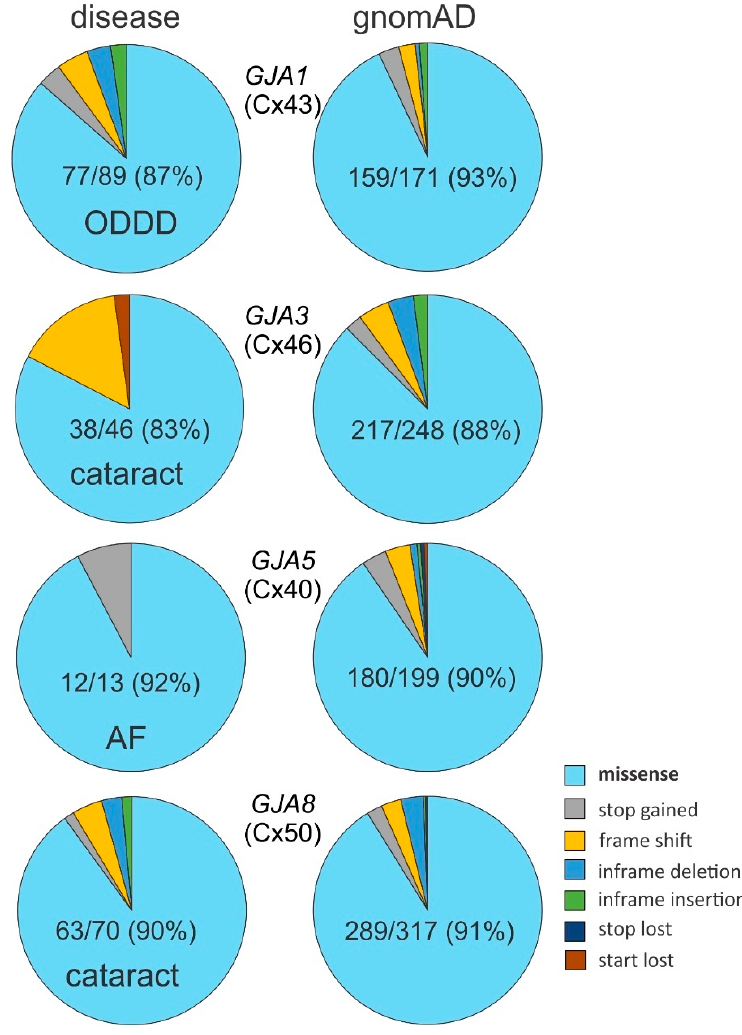
Figure 3. Missense variant is dominant among all variant types. Pie charts to illustrate that the number of unique missense variants is dominant in all variants observed in these four connexins irrespective to disease- or gnomAD-linked. Disease-linked variants pie charts are on the left (disease name is indicated on each pie) and the gnomAD-linked variants pie charts are on the right. Missense variants (light blue color) and their percentages are indicated. The relative distribution of disease- linked missense variants is not statistically different from that of gnomAD-linked missense variants for each of these connexins (Fisher’s exact test, p > 0.05 for each pair). Note, the synonymous variants were removed from the gnomAD-linked variants for easier comparison with those disease-linked variants. AF, atrial fibrillation; ODDD, oculodentodigital dysplasia.